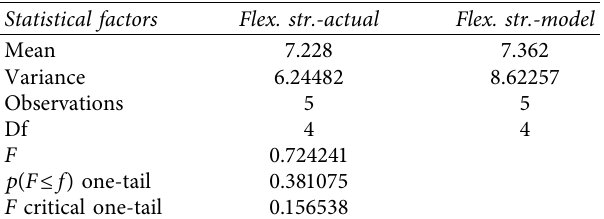
Table 28: F -Test two-sample for variances for flexural strength response.